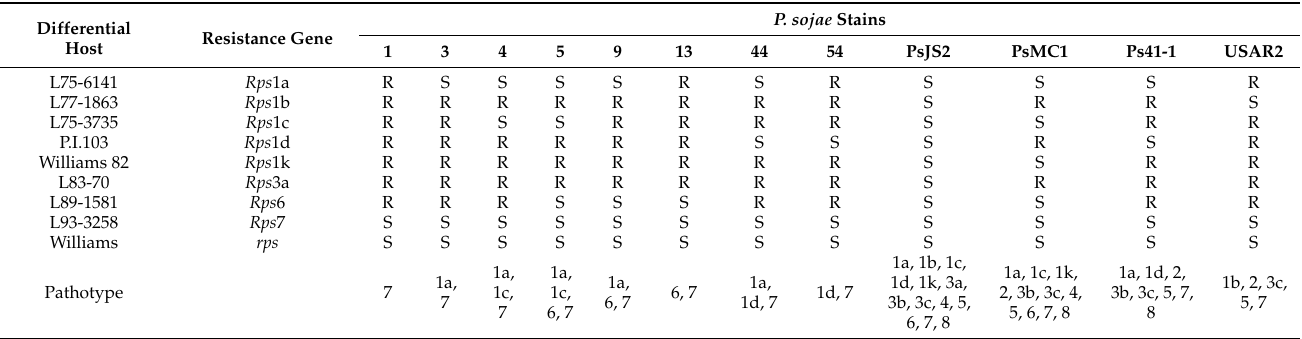
Table 3 contains a list of the virulence pathotypes against different cultivars. Table 3. Virulence reaction of P. sojae strains on differential